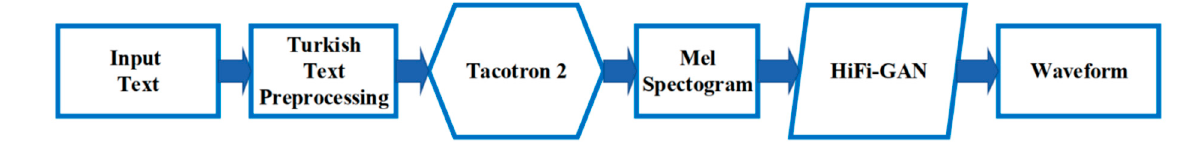
Figure 4. Tacotron 2 + Hi-Fi-GAN pipeline.